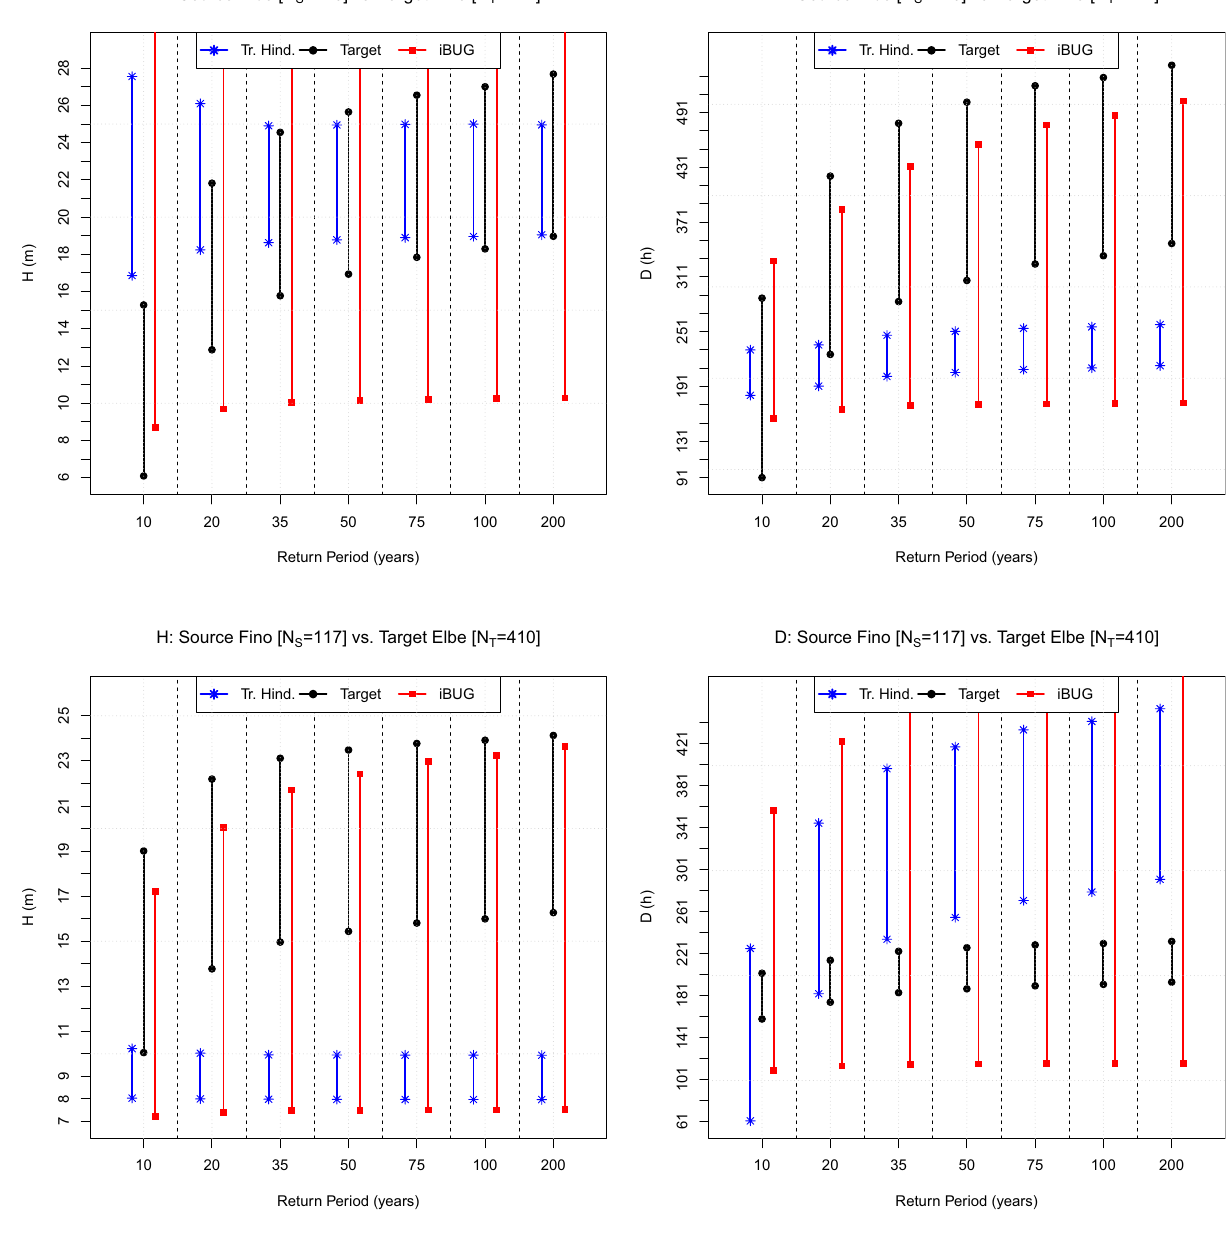
Figure 3. Comparison of Design values: the North Sea case. The plot shows the CI’s of the Target design values (black) associated with the RP’s indicated on the horizontal axis. The blue and red CI’s represent, respectively, the corresponding estimates computed via the Traditional Hindcasting and the iBUG techniques. The variables of interest ( H and D ) are indicated in the title, as well as the labels of the buoys considered and the Source ( N S ) and Target ( N T ) sample